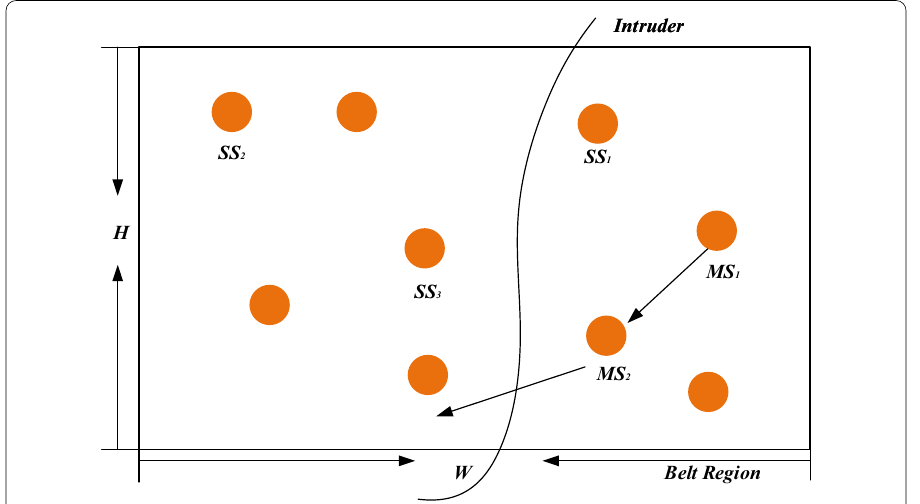
Fig. 1 Schematic diagram of wireless sensor node intrusion and scene